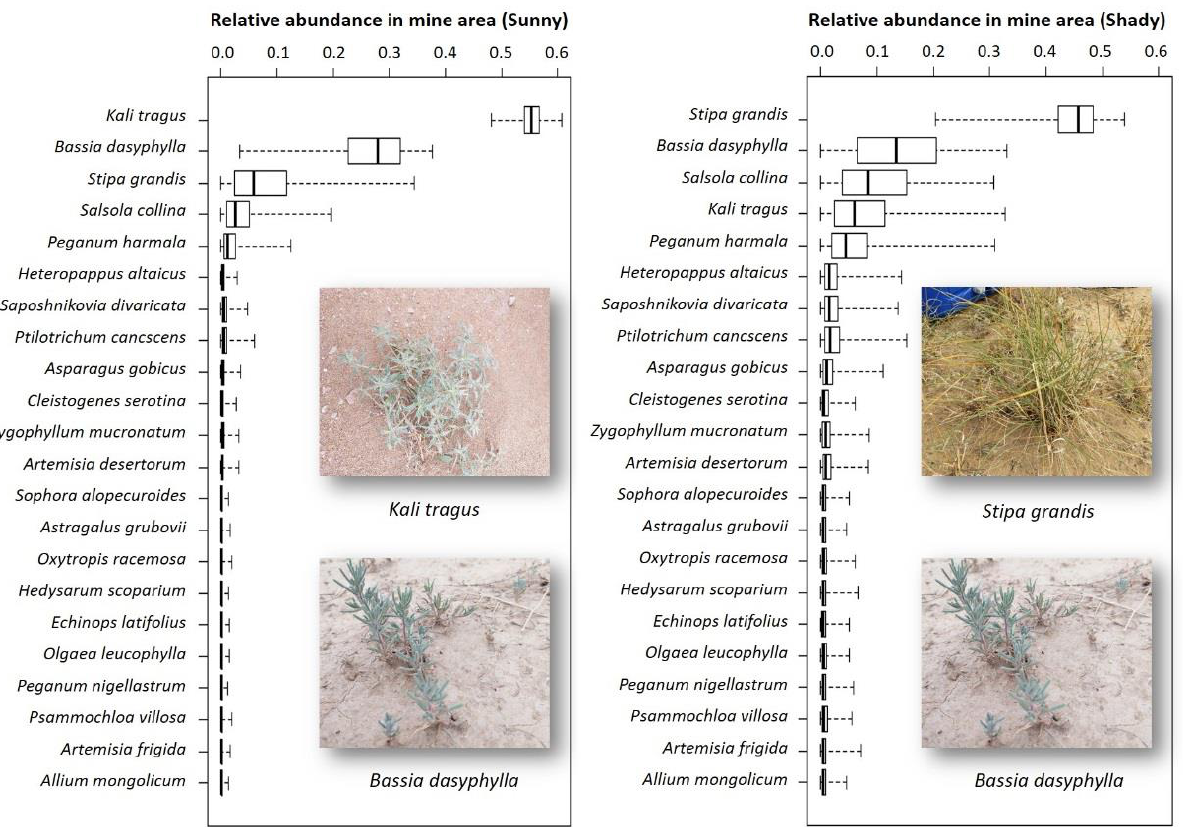
Figure 4. The relative abundances of the species in sunny or shady slope of mine area obtained by the CATS model.